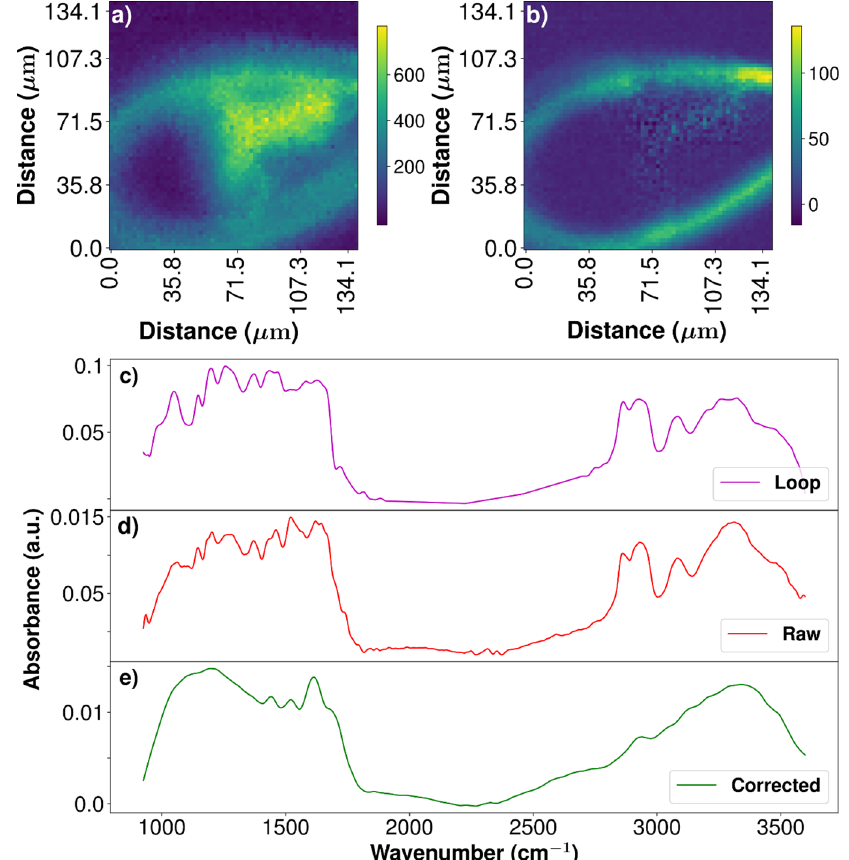
Figure A3. ( a ) Full range (900–3600 cm − 1 ) integration of a reference map. ( b ) Loop identification as extracted using the developed software: from the correction output, the loop contribution coefficients were taken and used for 3D rendering of the sample support. ( c ) Average spectrum of the nylon loop ( d ) Raw spectrum ( e ) Corrected spectrum as obtained using the developed software.